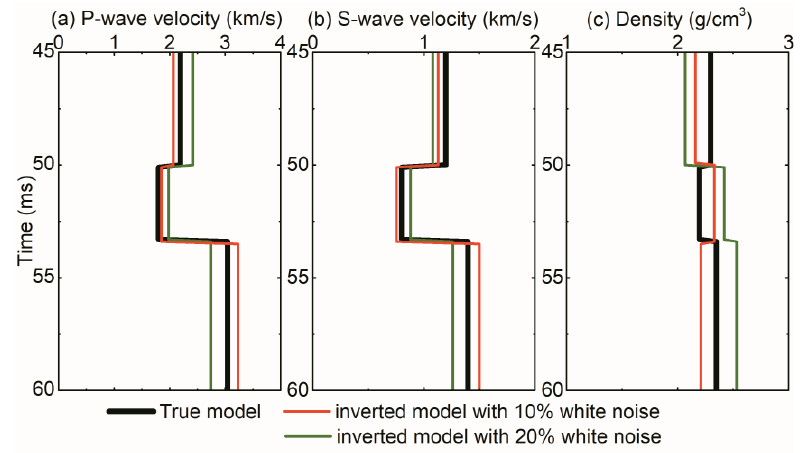
Figure 9. Inversion results of Model 3’s amplitude versus angle (AVA) records with 10% and 20% white noise by the linear analytic approximation: ( a ) P-wave velocity; ( b ) S-wave velocity; ( c ) density.